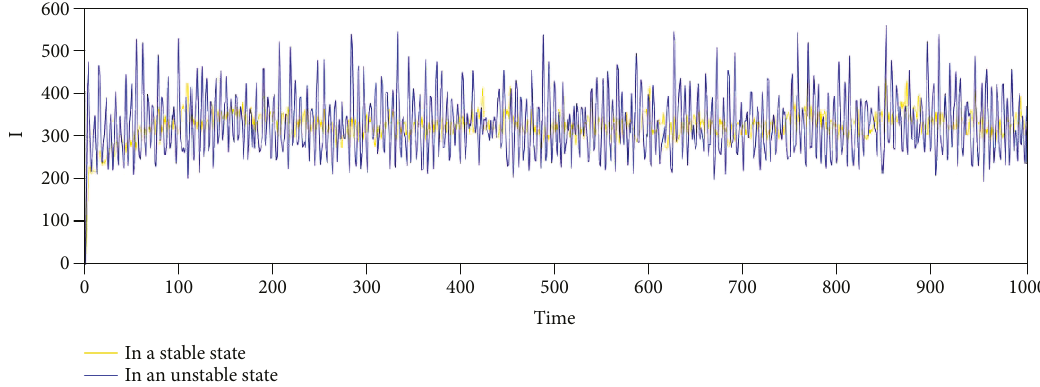
Figure 17: Comparison of initial inventory changes of the warehousing system in a stable state and unstable state under the scenario of random demand obeying uniform distribution.